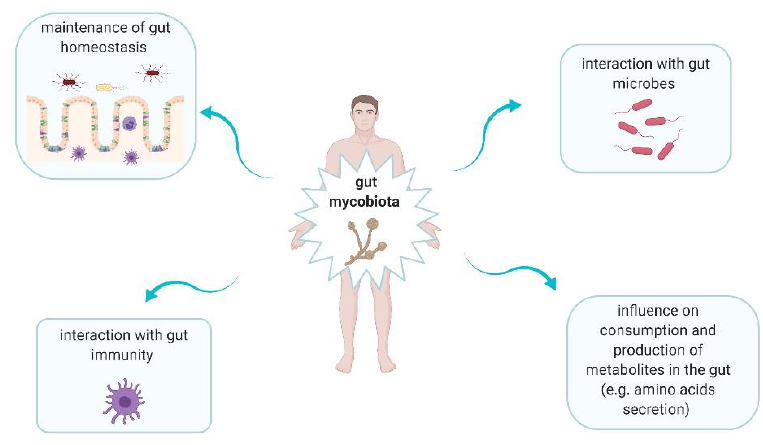
Figure 2. The main roles of gut mycobiota in human body